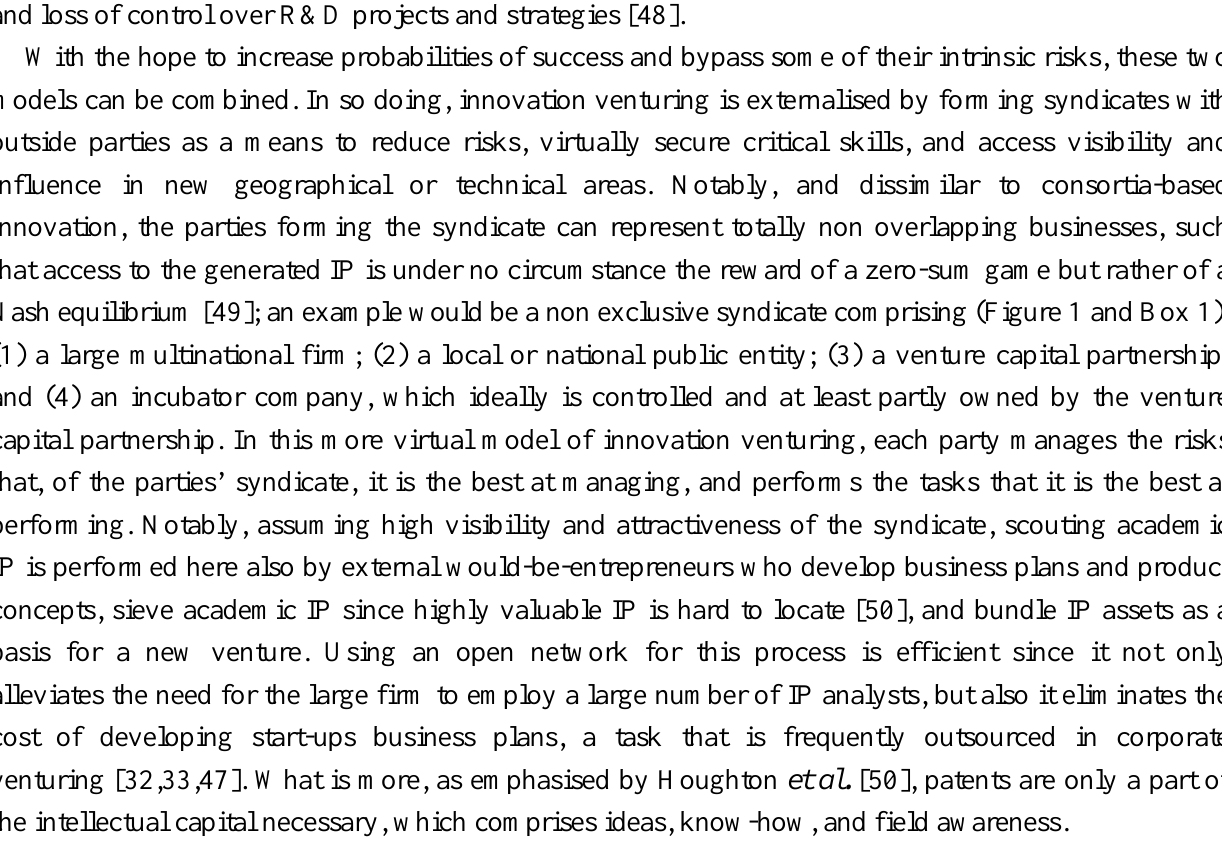
Figure 1. Syndicated innovation venturing. IP: intellectual property. FTO: freedom to operate. ROI: return on investment. VC: venture capital